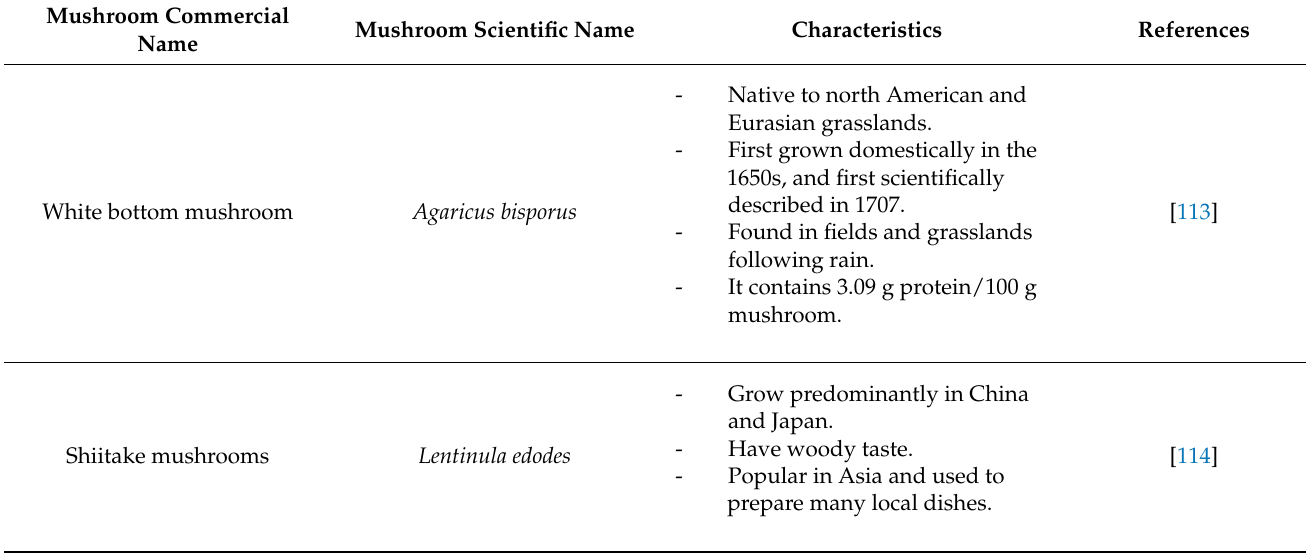
Table 2. Some edible mushrooms and their